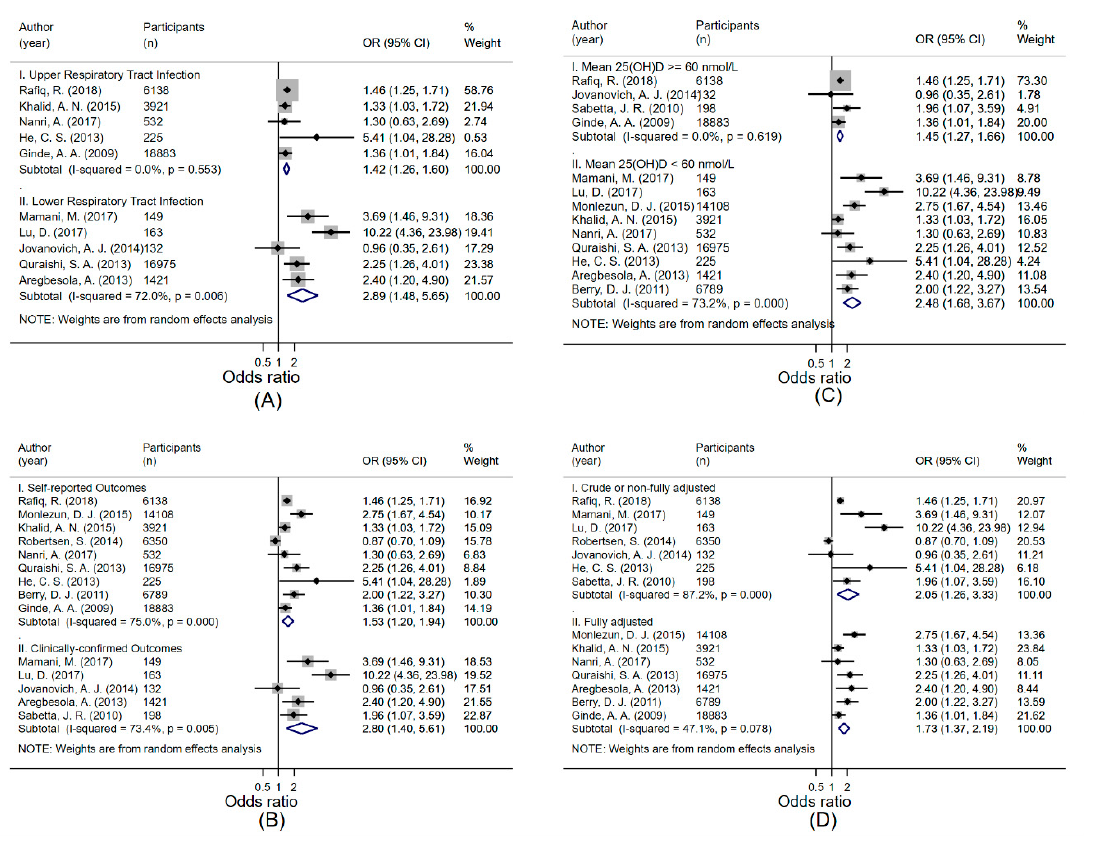
Figure 6. Forest plot displaying odds ratios (95% confidence intervals) for the association between 25(OH)D concentration and ( A ) (i) upper respiratory tract infection, and (ii) lower respiratory tract infection; ( B ) (i) self-reported, and (ii) clinically confirmed acute respiratory tract infection; ( C ) acute respiratory tract infection in studies with (i) mean 25(OH)D concentration ≥ 60 nmol/L, and (ii) mean 25(OH)D concentration < 60 nmol/L; and ( D ) acute respiratory tract infection in studies with (i) crude or non-fully adjusted effect estimate; and (ii) fully adjusted effect estimate; comparing the lowest versus the highest 25(OH)D category.